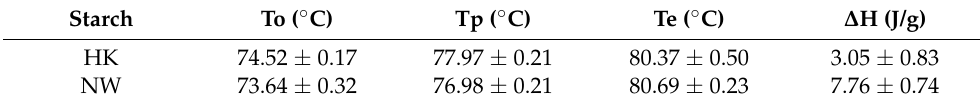
Table 1. Thermal properties of HK and NW banana starch obtained using DSC